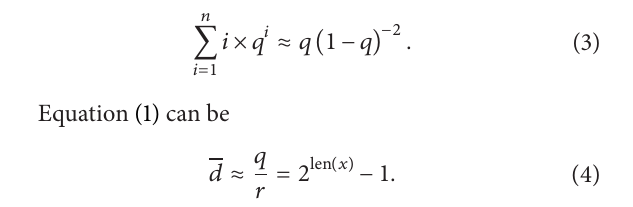
Figure 8: The good suffix matching of pattern bit string.